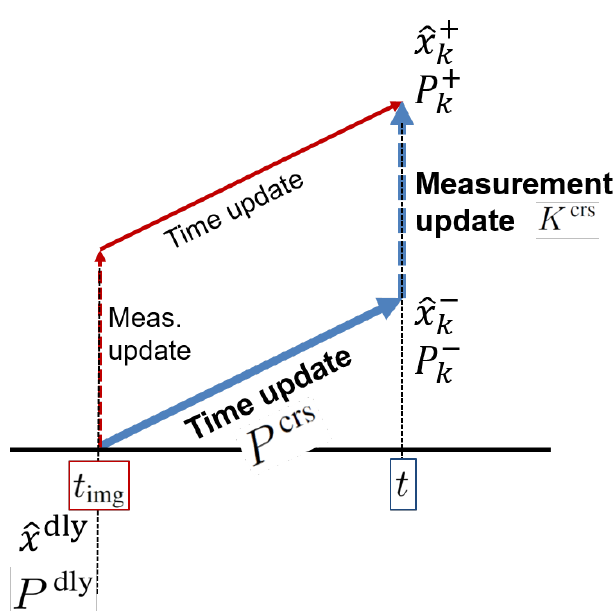
Figure 4. A schematic of a modified measurement update using covariance